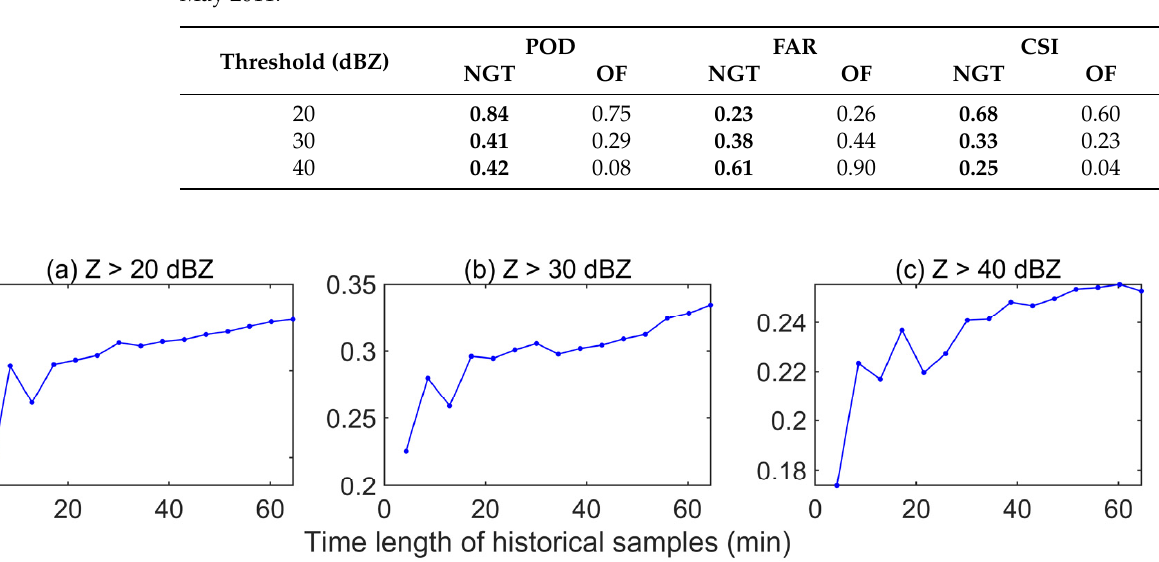
Figure 7. The CSI of 60 min prediction by NGT using different time lengths of historical samples